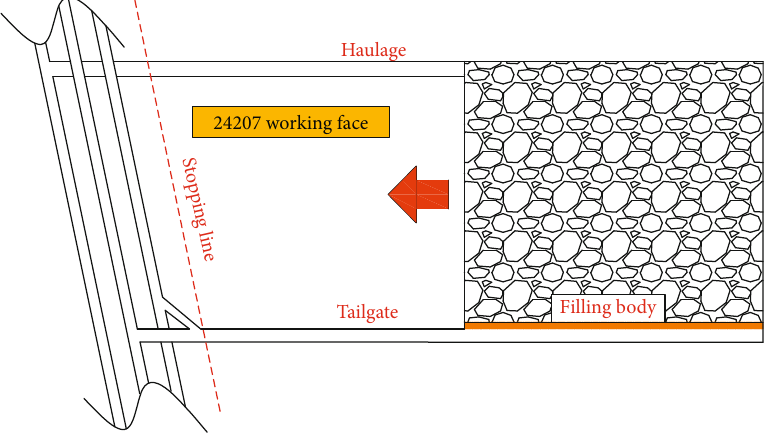
Figure 2: Working face